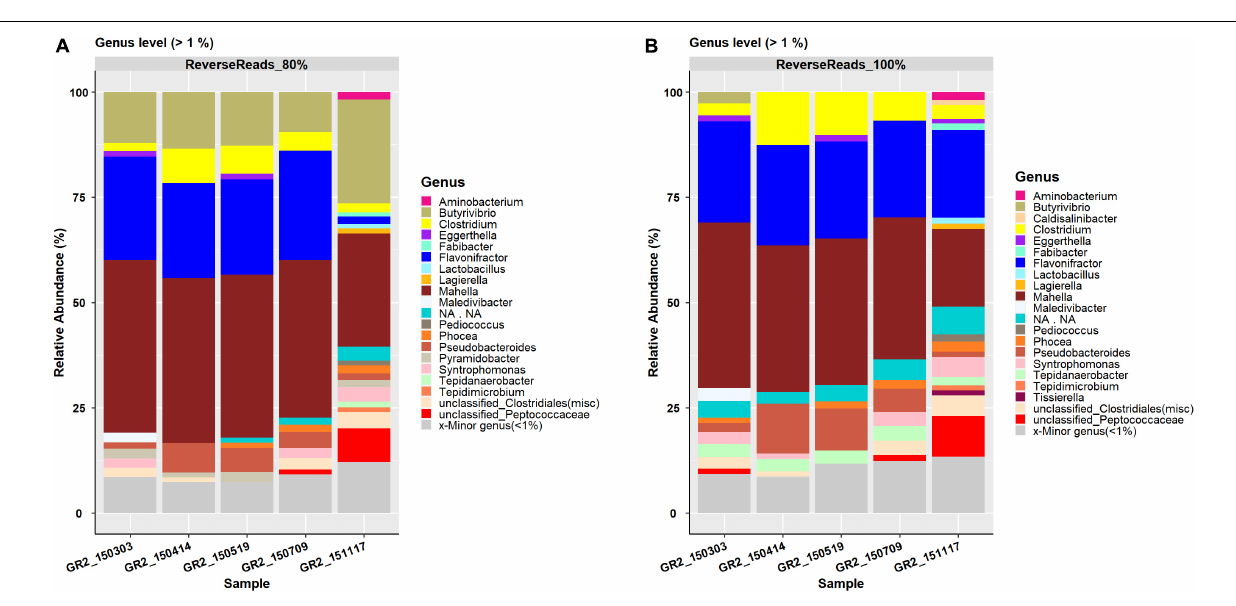
FIGURE 2 | Reverse reads processing result representation of the genus-level bar plot with relative abundance > 1% for the data processed at a clustering threshold of (A) 80% and (B) 100%. Genera with relative abundance < 1% are merged in the category ‘Minor